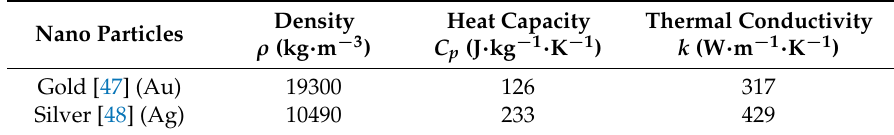
Table 2. Physical properties of the